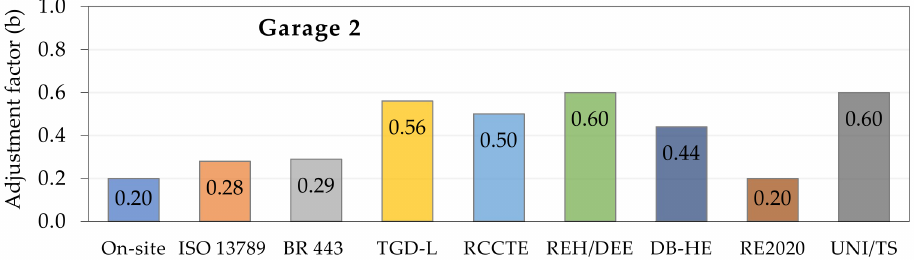
Figure 21. Comparison of the adjustment factor values (b) for Garage